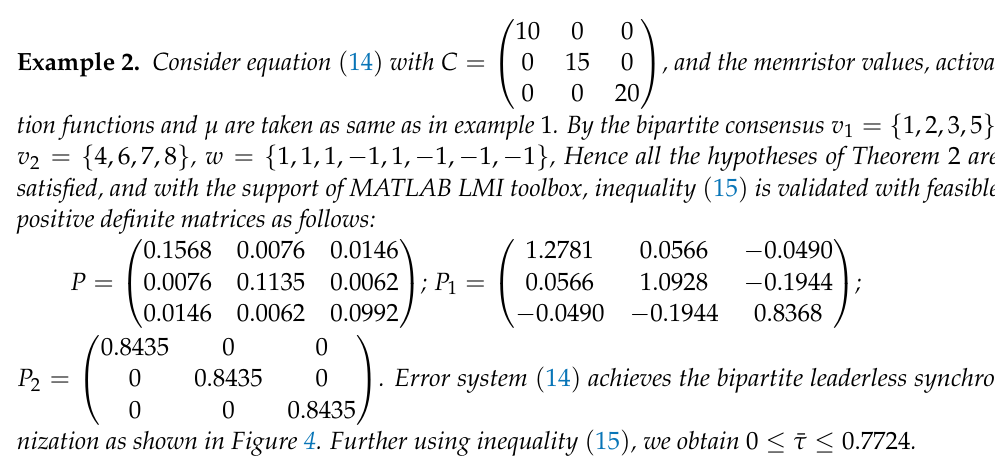
Figure 3. Bipartite leader synchronization of signed graph with eight